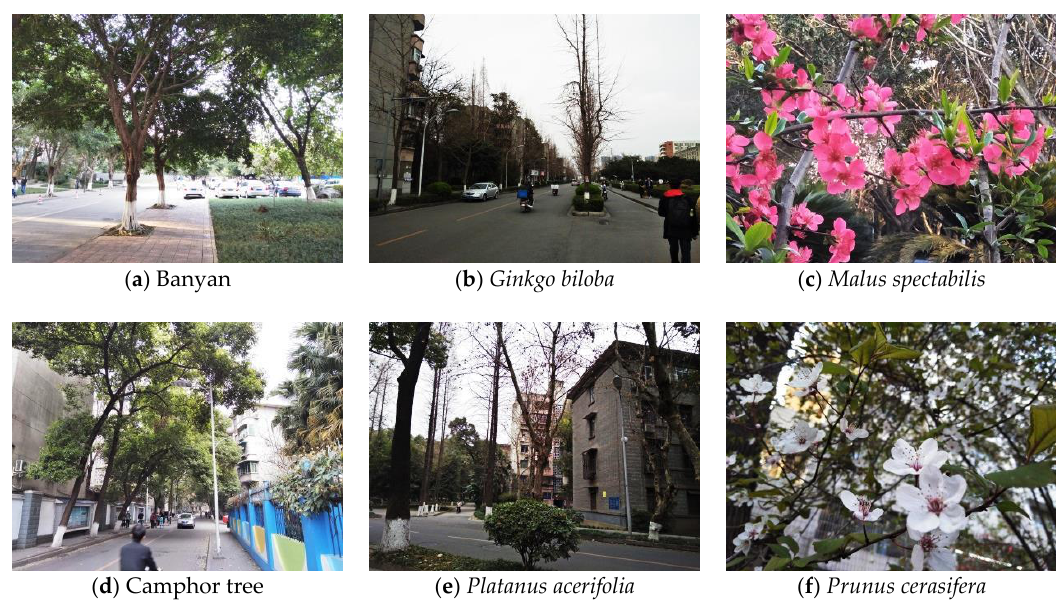
Figure 8. Campus Vegetation of Wangjiang Campus, Sichuan University.